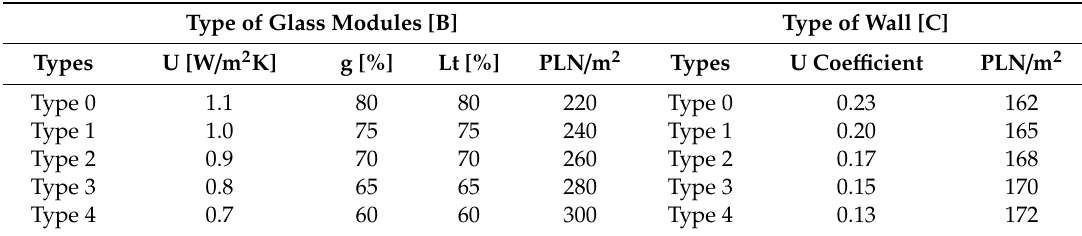
Table 7. Table 7 Scope and values assigned to optimization Table 7 Scope and values assigned to optimization variables.